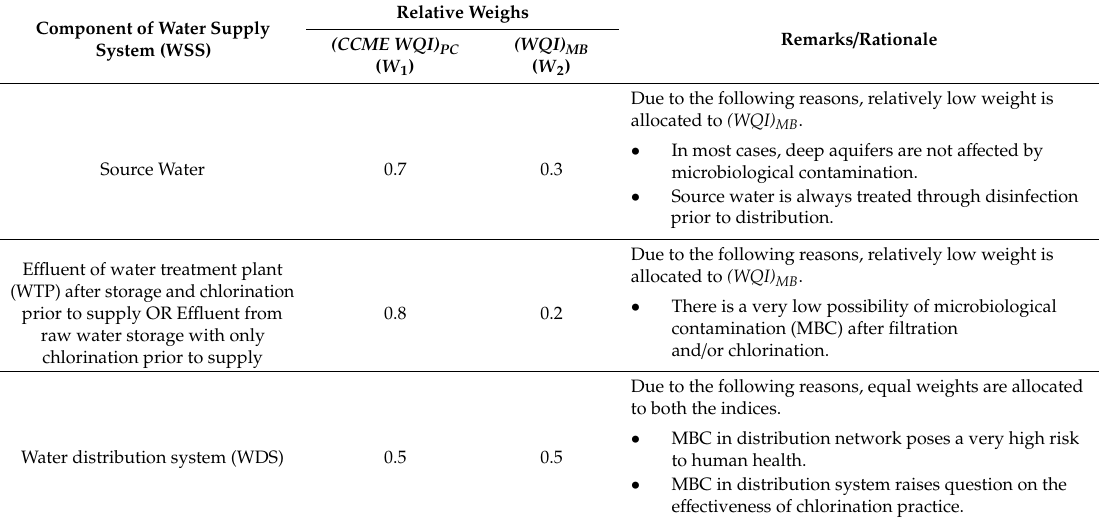
Table 1. Weighting scheme for di ff erent components of a WSS to calculate (CCME WQI) Modified . Component of Water Supply System